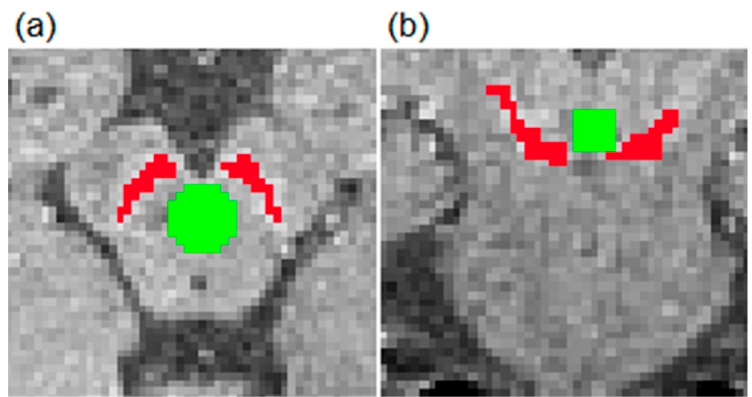
Figure 2. Presentation of areas for signal intensity (SI) analysis in the transverse ( a ) and coronal ( b ) planes. SI SN and SI background were defined as shown with red and green colors, respectively. SN: substantia nigra.